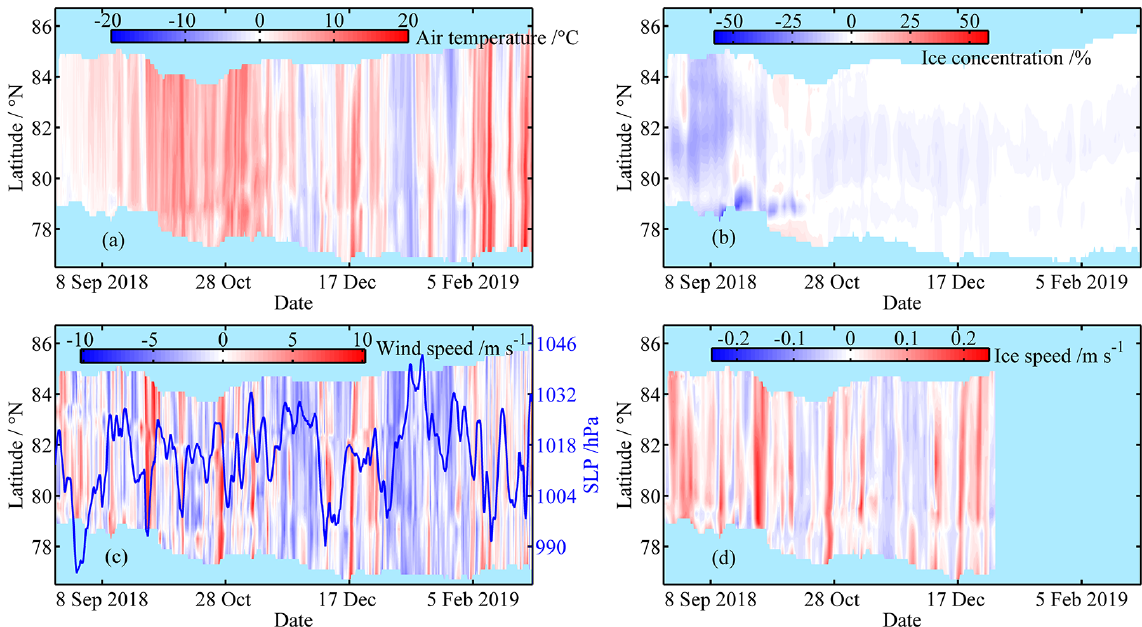
Figure 6. Meridional and temporal changes in anomalies of (a) T 2m , (b) ice concentration, (c) wind speed, and (d) ice speed in the ice season 2018/19 relative to 1979–2018 climatology; (c) the blue line indicates SLP averaged over the study region.